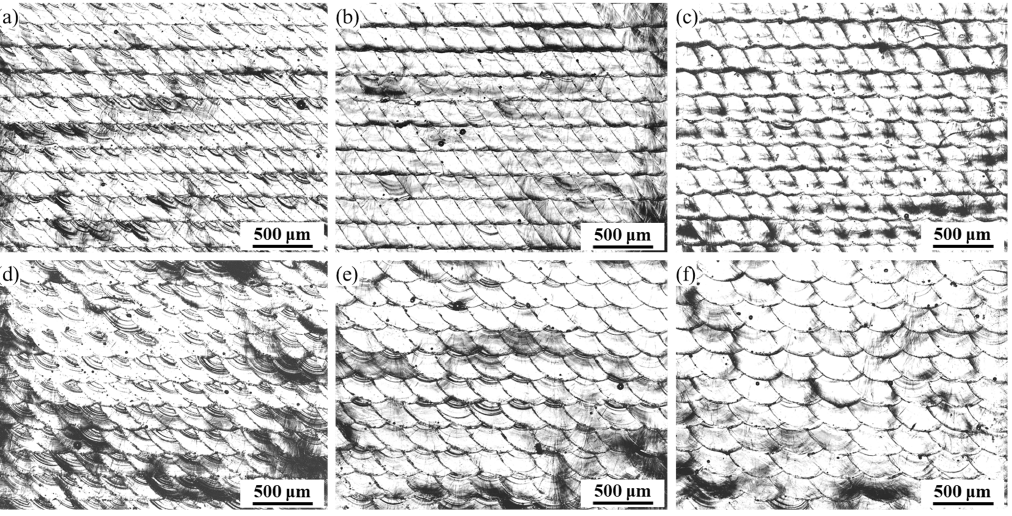
Figure 9. Surface topography: OL 66%, W : ( a ) 0.3 mm, ( b ) 0.4 mm, ( c ) 0.5 mm, OL 50%, W : ( d ) 0.3 mm, ( e ) 0.4 mm, ( f ) 0.5 mm.